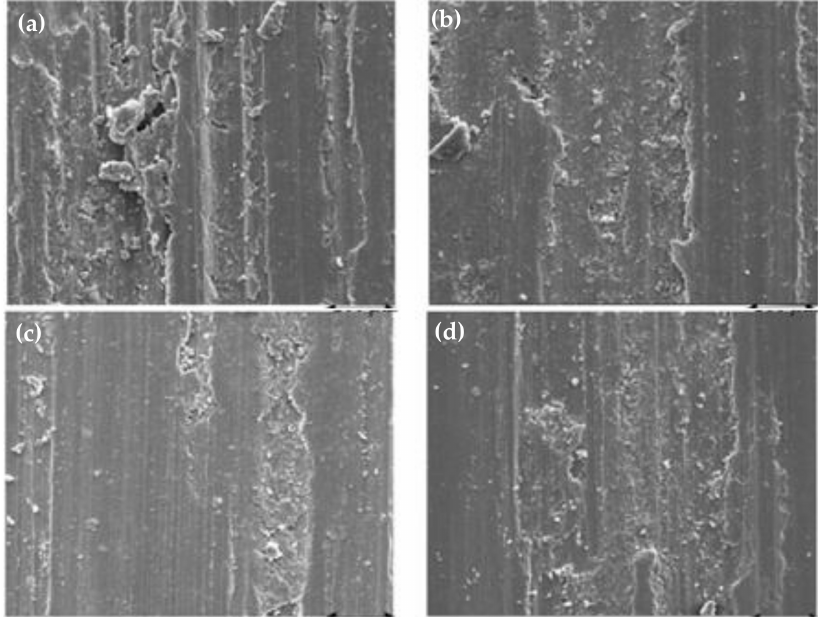
Figure 18. SEM images of the worn surfaces of Al6061 alloy and Al6061/silicon carbide-reinforced composites at a 60 N applied force and a sliding distance of 6 km ( a ) Cast Al6061 alloy ( b ) Al6061-2 wt% SiC ( c ) Al6061-4 wt% SiC ( d ) Al6061-6 wt% SiC